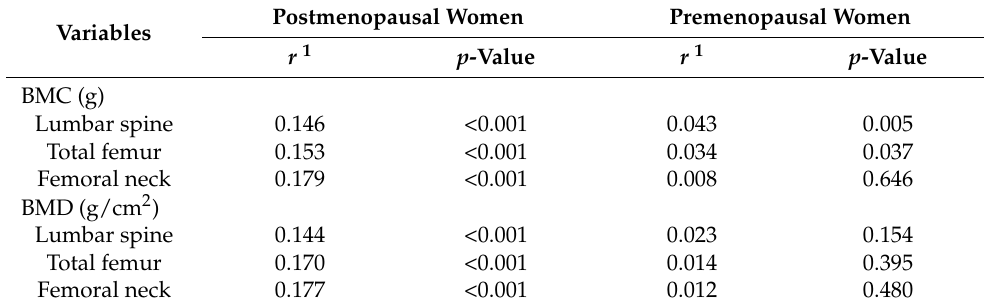
Table 3. Correlation of dietary total antioxidant capacity (TAC) with bone mass.